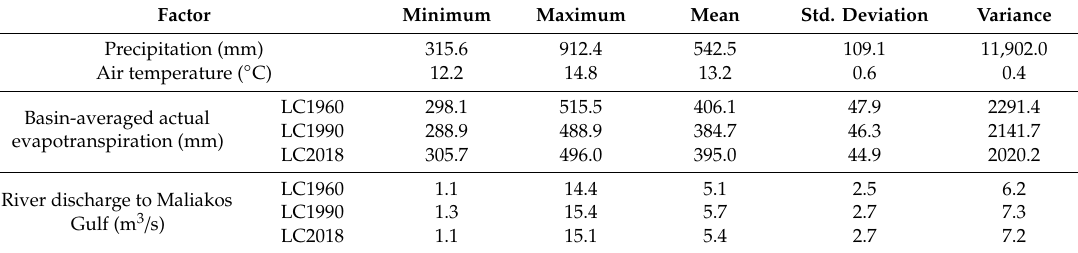
Table 7. Descriptive statistics for the annual time-series of the main hydrometeorological factors. Factor Minimum Maximum Mean Std. Deviation Variance Precipitation